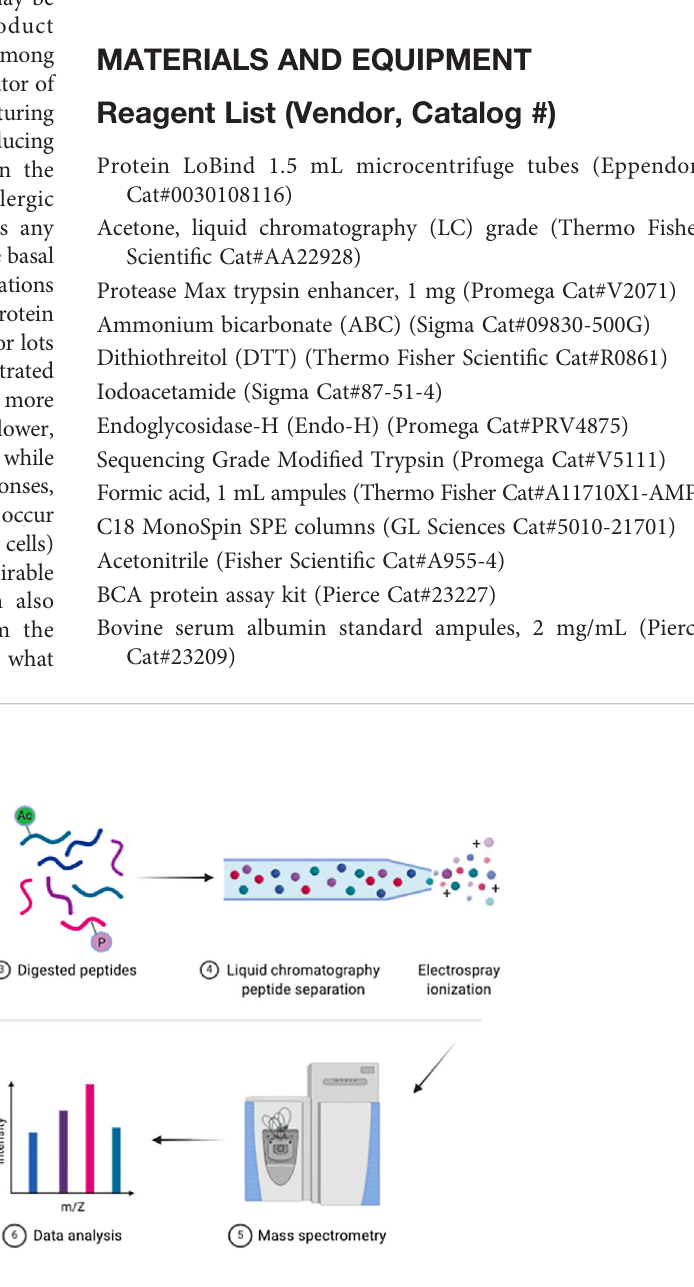
FIGURE 1 | Bottom-up rAAV proteomic work fl ow. Schematic of key steps in the vector preparation for LC-MS/MS and subsequent data analysis